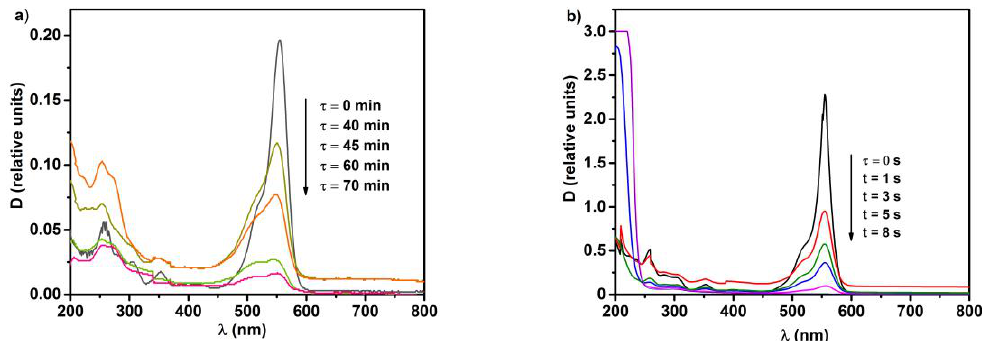
Figure 8. Changes in the UV-Vis spectra of RhB solutions during the treatment by ( a ) UV photolysis and ( b ) DBD in the presence of the photocatalyst TiO 2 -PMMH.